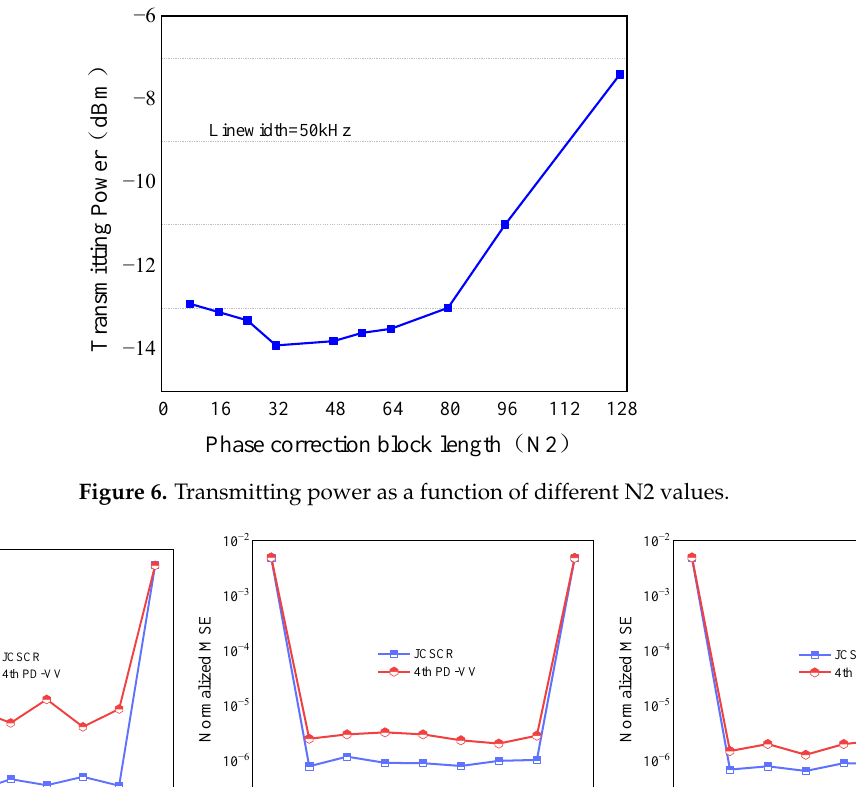
Figure 6. Transmitting power as a function of different N2 values.